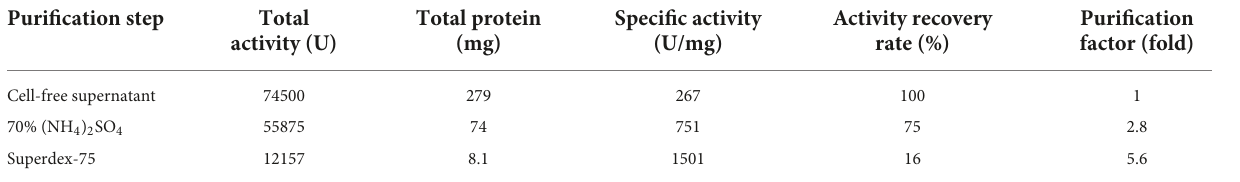
( Figure 5A ), and the optimal pH is 9.0 ( Figure 5B